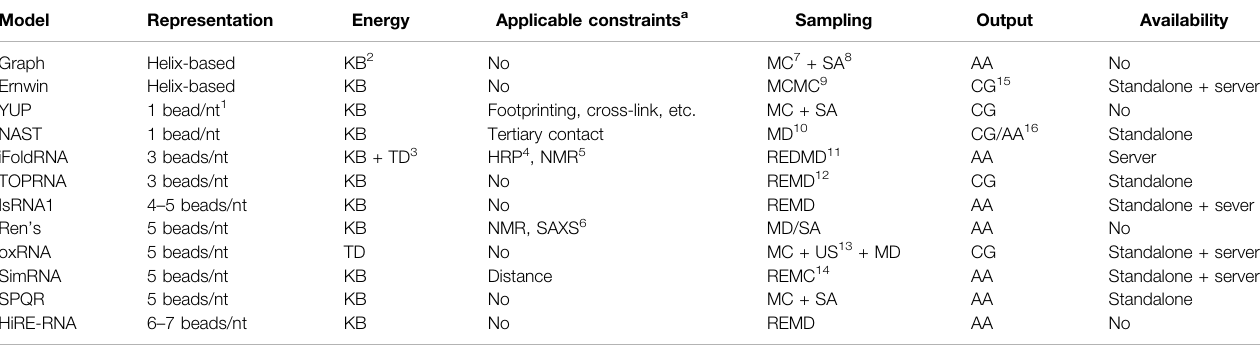
TABLE 1 | Summary of CG models for RNA 3D structure modeling.